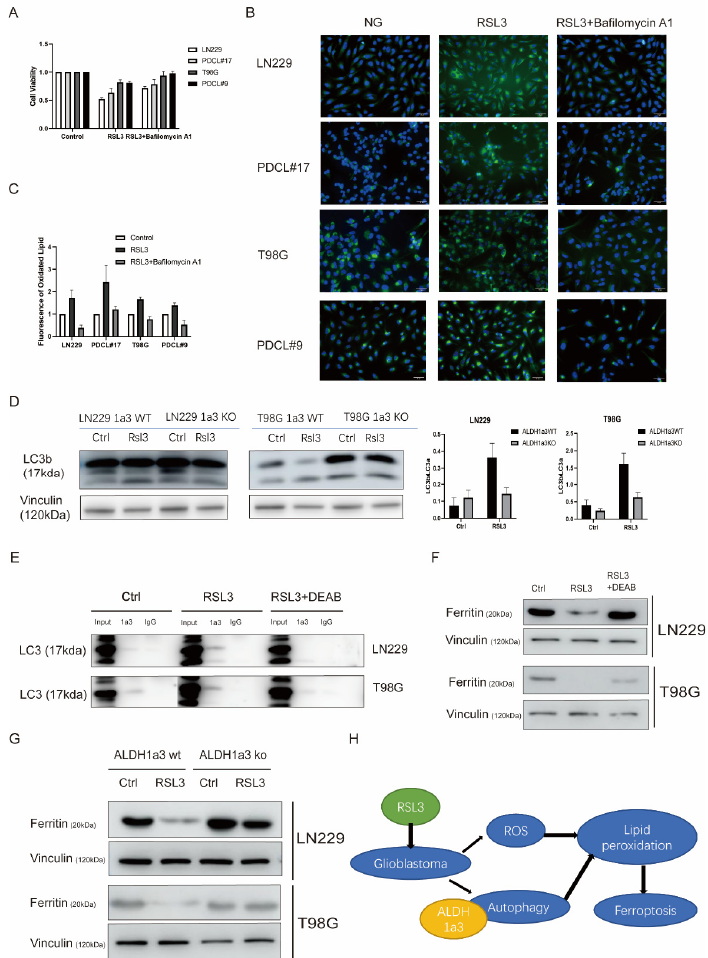
Figure 4. Autophagy in RSL3-induced cell death. ( A ) Cell viability after RSL3 with or without Bafilomycin A1 in LN229, PDCL#17, T98G, and PDCL#9 showed reversion of cell viability by autophagy inhibition by bafilomycin A1 ( p -value: LN229 RSL3 vs. RSL3 + Bafilomycin A1 < 0.01; PDCL#17 RSL3 vs. RSL3 + Bafilomycin A1 < 0.01). ( B ) BODIPY 581/591 C11 staining of lipid peroxidation after RSL3 treatment with or without Bafilomycin A1 showed a significant reduction in fluorescence staining after autophagy inhibition. ( C ) Quantification of lipid peroxidation after RSL3 with or without Bafilomycin A1 treatment. ( D ) Western blot analysis and quantification of LC3B/LC3A ratio of ALDH1a3 wildtype and knockout cells showed a pronounced induction of autophagy in wildtype cells but not in ALDH1a3 knockout cells. Vinculin served as control. ( E ) Immunoprecipitation assays of LN229 and T98G cells; protein complexes were precipitated with ALDH1a3 antibodies after RSL3 treatment with or without DEAB. Immunoblots showed ALDH1a3 binding to LC3 after RSL3 treatment that could be reverted by concomitant DEAB treatment. ( F ) Western blot analysis of ferritin expression after RSL3 treatment with and without DEAB in LN229 and T98G cells. Ferritin iron storage was downregulated after RSL3 treatment, which could be reversed by concomitant DEAB treatment. Vinculin served as control. ( G ) Western blot analysis of ferritin expression after RSL3 treatment in LN229 and T98G ALDH1a3 wildtype or ALDH1a3 knockout cells. The results corroborated the results of (F), showing ferritin downregulation after RSL-3 treatment only in ALDH1a3 wildtype cells. ( H ) Schematic diagram: RSL3 treatment induces ROS accumulation and activates ALDH1a3-dependent autophagy in glioblastoma cells, leading to lipid peroxidation and finally to